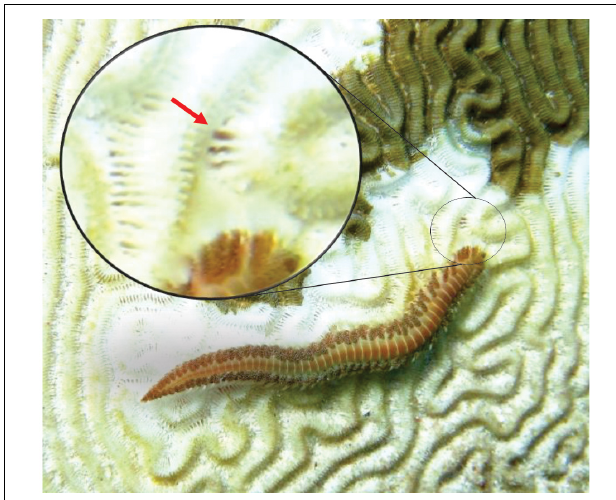
FIGURE 9 | Fireworm H. carunculata , apparently consuming the death tissue of P. strigosa . A red arrow in the magnified area shows remaining tissue between skeletal septa. Picture of March